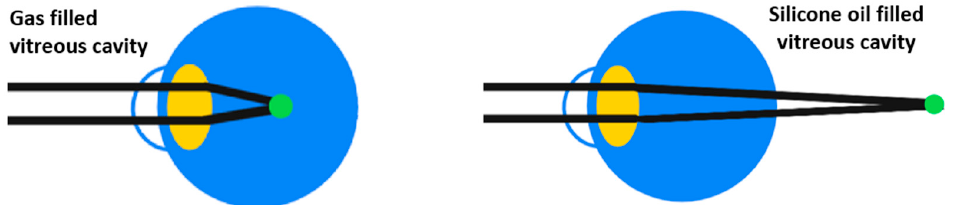
Figure 5. A gas filled vitreous chamber ( left ) has a higher difference in refractive index between the posterior face of the crystalline lens than vitreous and an even higher difference than silicone oil ( right ). The result is a surgically induced myopia in case of a gas filled vitreous cavity and a surgically induced hyperopia in case of a silicone oil filled vitreous cavity.